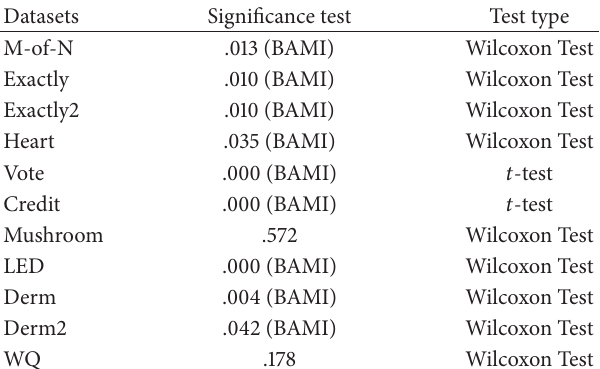
Table 3: Significant test.